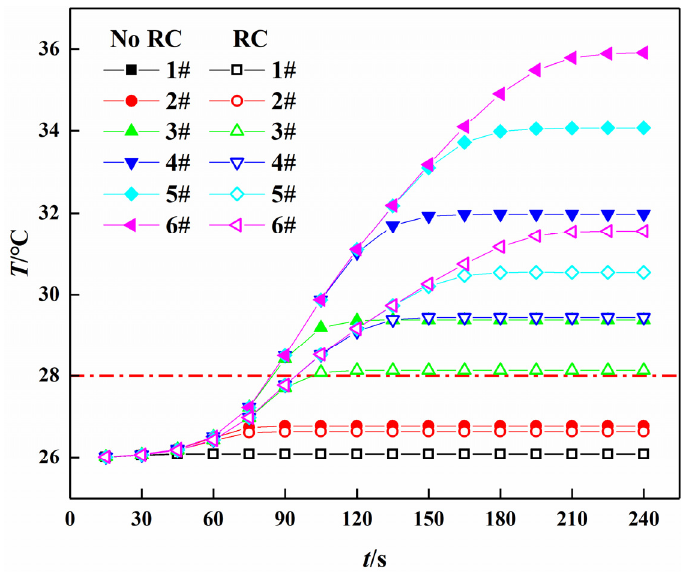
Figure 12. Temperature changes of each measuring point along the working face before and after cooling under the most unfavorable conditions. Table 6. Temperature of measuring point 1-6 under most unfavorable conditions.